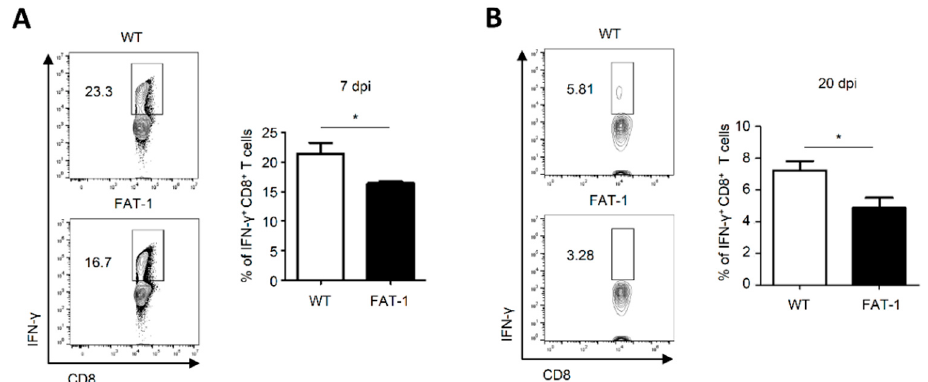
Figure 3. Anti-viral CD8 + T cell responses in peripheral blood were reduced in FAT-1 mice. WT and FAT-1 mice were infected with LCMV (Armstrong). Peripheral blood mononuclear cells were isolated from blood that was collected at 7 ( A ) or 20 ( B ) days post-infection. After stimulation with LCMV GP33 peptide, the expression of IFN- γ was analyzed using flow cytometry. The representative flow cytometry plots were shown (left panels) and the bar graph shows the percentage of IFN- γ + CD8 + T cells (right panels). The data represent the mean ± SEM ( n = 4–5 mice per group). * p ≤ 0.05. The data represent the results of at least three independent experiments.